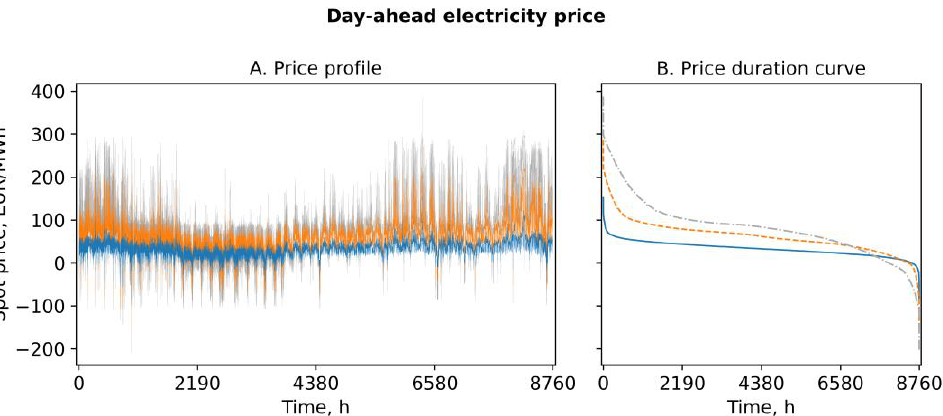
Figure 4. Comparison of the historical and forecasted (FC) electricity wholesale price profiles ( A ) duration curves ( B ) for 2020 (blue), 2030 (orange), and 2050 and duration curves ( B ) for 2020 (blue), 2030 (orange), and 2050 (grey).